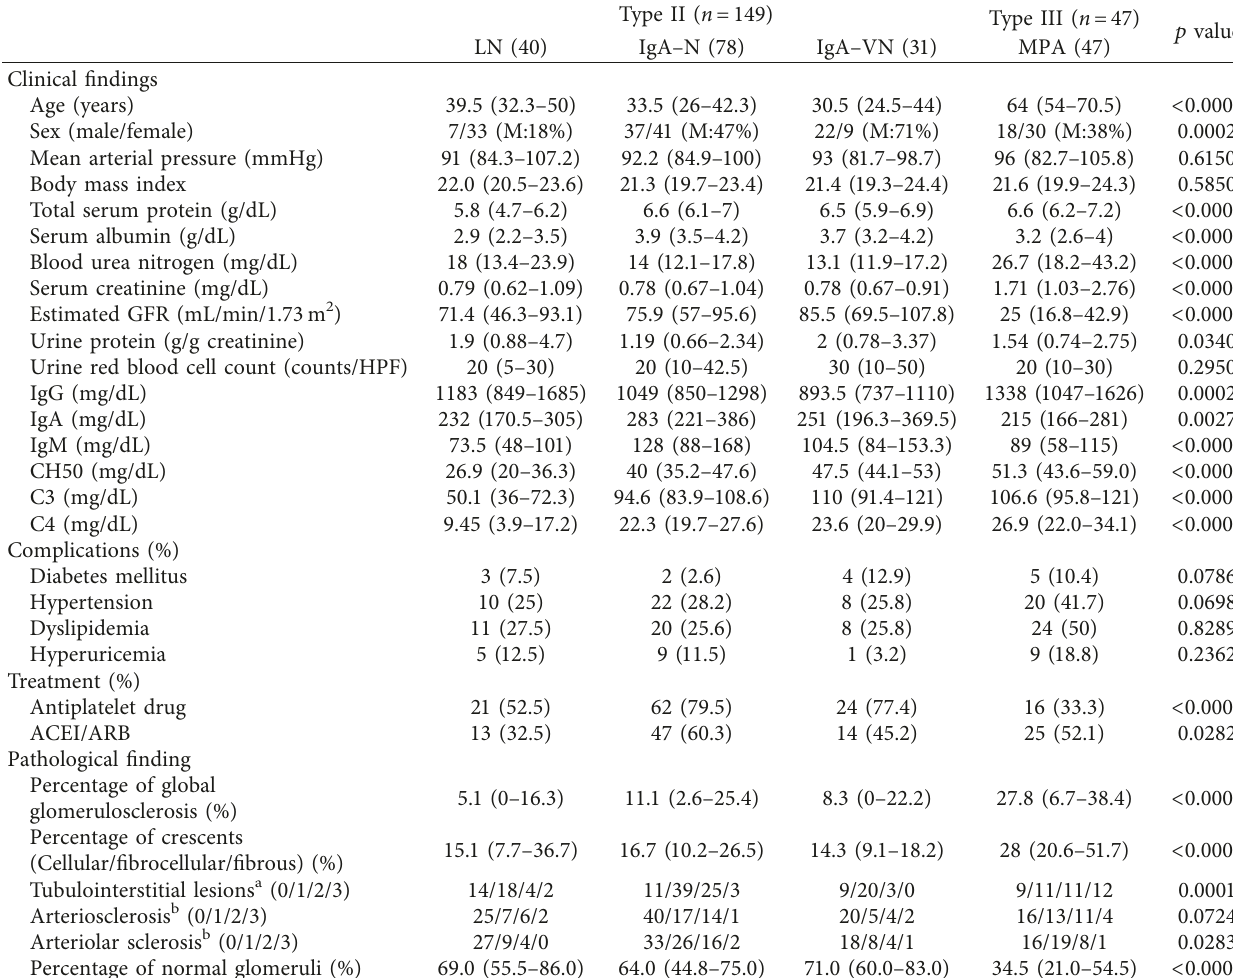
Table 1: Clinical and pathological findings according to the four classifications of rapid progressive